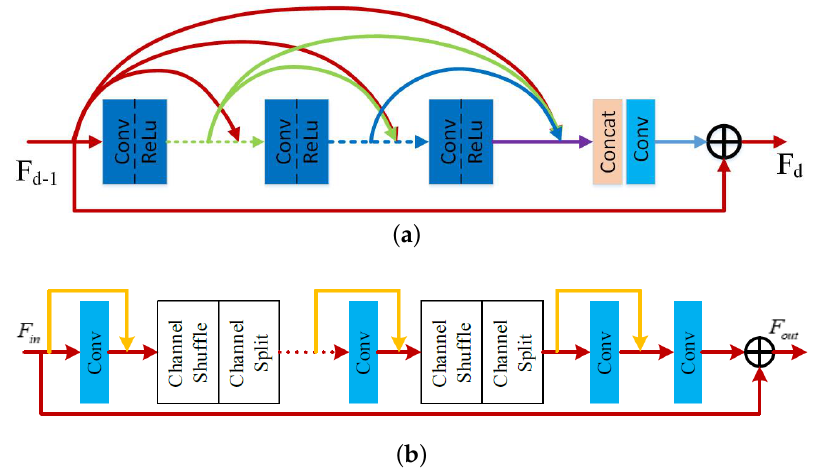
Figure 4. Comparison of the structures of the residual dense block (RDB) used in [19,20] and our lightweight RDB. ( a ) Existing RDB [19,20]. ( b ) Our lightweight